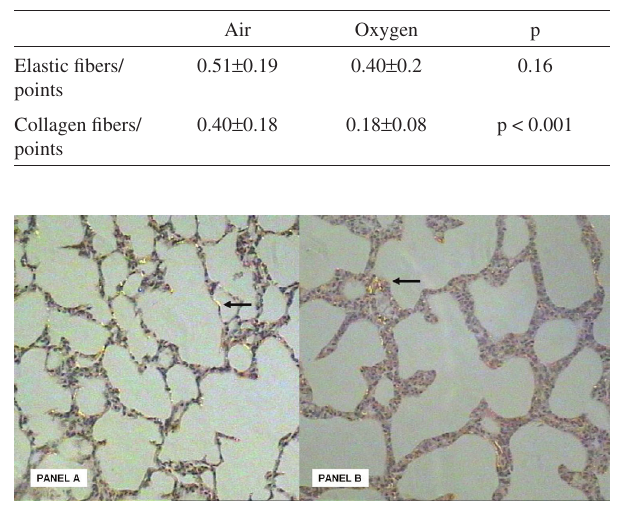
Figure 2 - Panel A: Picrosirius stained section (magnification X20). Col- lagen fiber deposition in lung parenchyma at the 11th day of life (arrow) at room air. Panel B: After 11 days of hyperoxic challenge there is an evident disordered deposition of the collagen fibers in the lung intersticium (arrow).